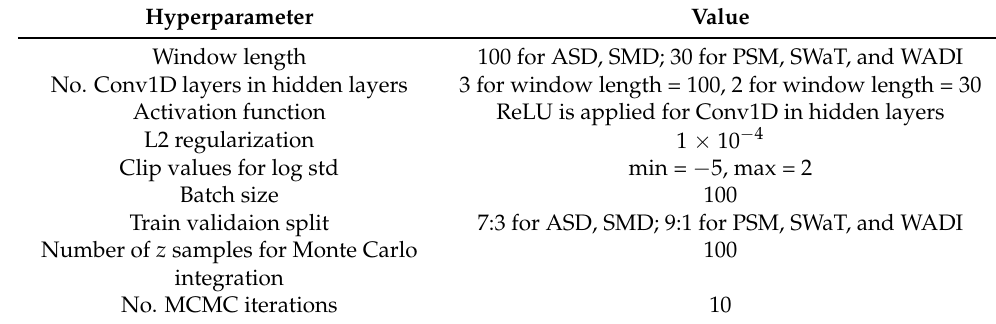
Table 2. Hyperparameters values used in